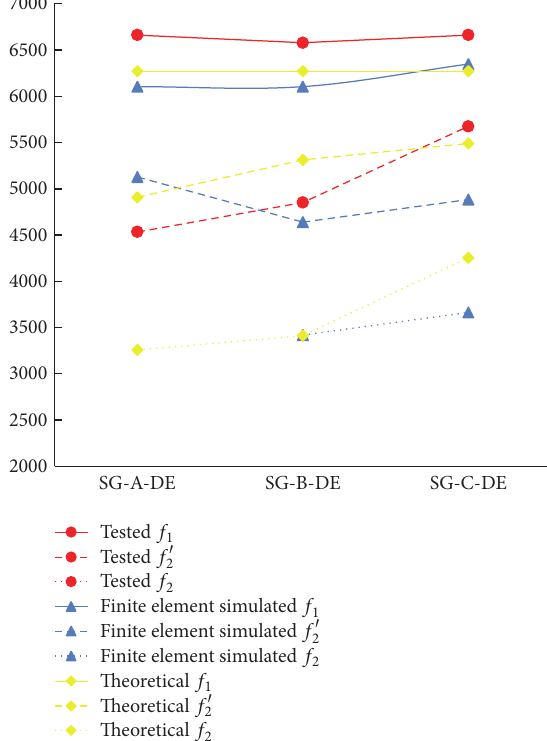
Figure 13: Comparison of theoretical values, test values, and finite element simulation values of peak frequency of samples (with